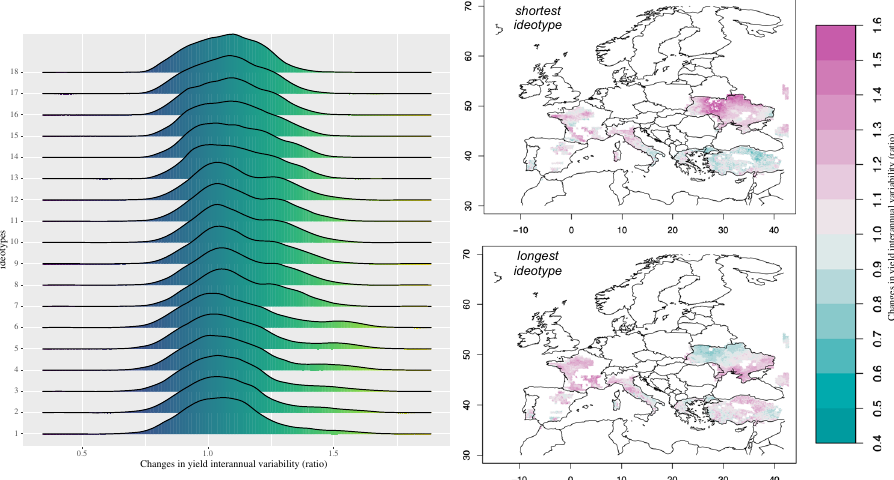
Fig. 3 Changes in yield interannual variability in 2021-2040 with no adaptation. Left Panel: Spatial probability density function of the ensemble changes in the yield interannual variability (ratio between 2021 – 2040 and 1986 – 2005) for each ideotype (from the shortest 1 to the longest 18). Right panel: Ensemble changes in the yield interannual variability (ratio between 2021 – 2040 and 1986 – 2005) of the shortest and longest ideotypes. Colours in the right panel are associated with the estimated